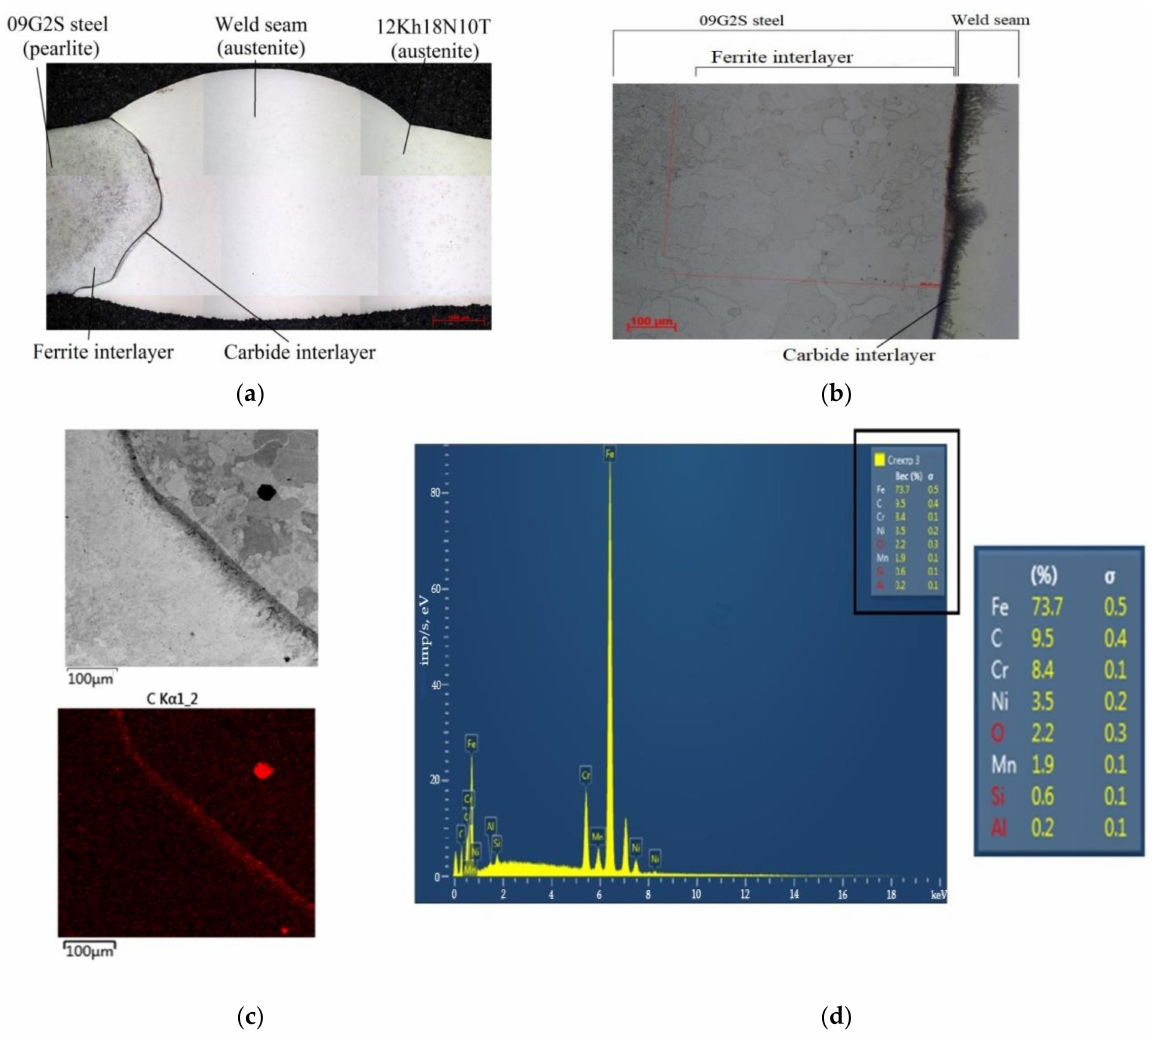
Figure 2. Welded joint of 09G2S and 12Kh18N10T steels after PWHT: weld ( a ) and cross-section of the fusion line from the side of 09G2S steel ( b ); SEM images ( c ) and EDX analysis results ( d ) of carbide